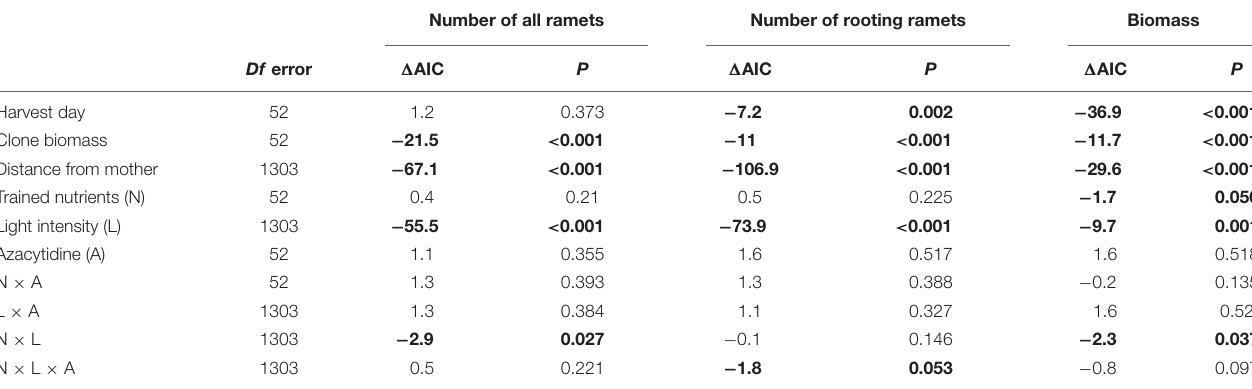
TABLE 2 | Testing zone only: the effect of previous training for nutrients to occur in shade or light on the behavior in light and shade patches without presence of nutrient patches. Number of all ramets Number of rooting ramets